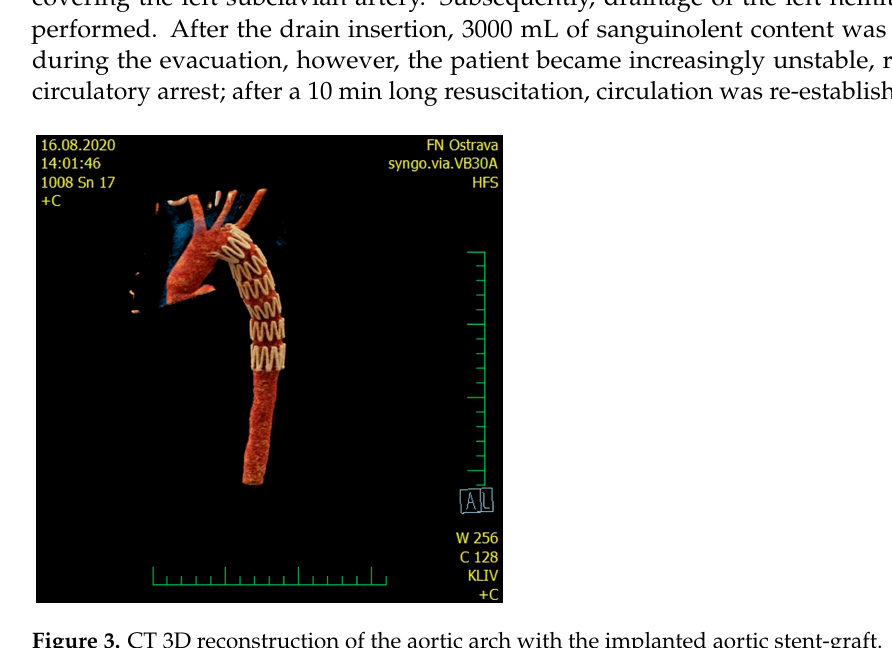
Figure 3. CT 3D reconstruction of the aortic arch with the implanted aortic